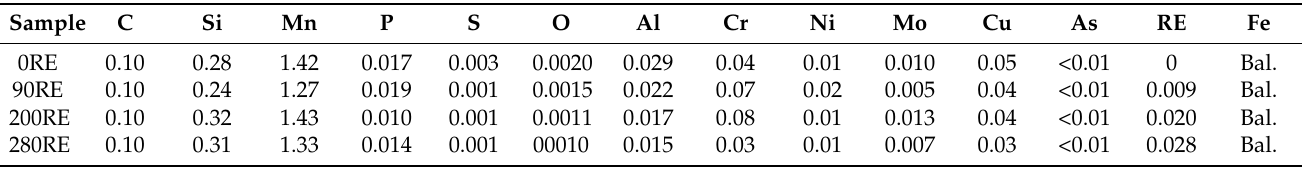
Figure 1. Industrial production process of the grade EH36 offshore engineering steels. Table 1. Chemical compositions of test steels